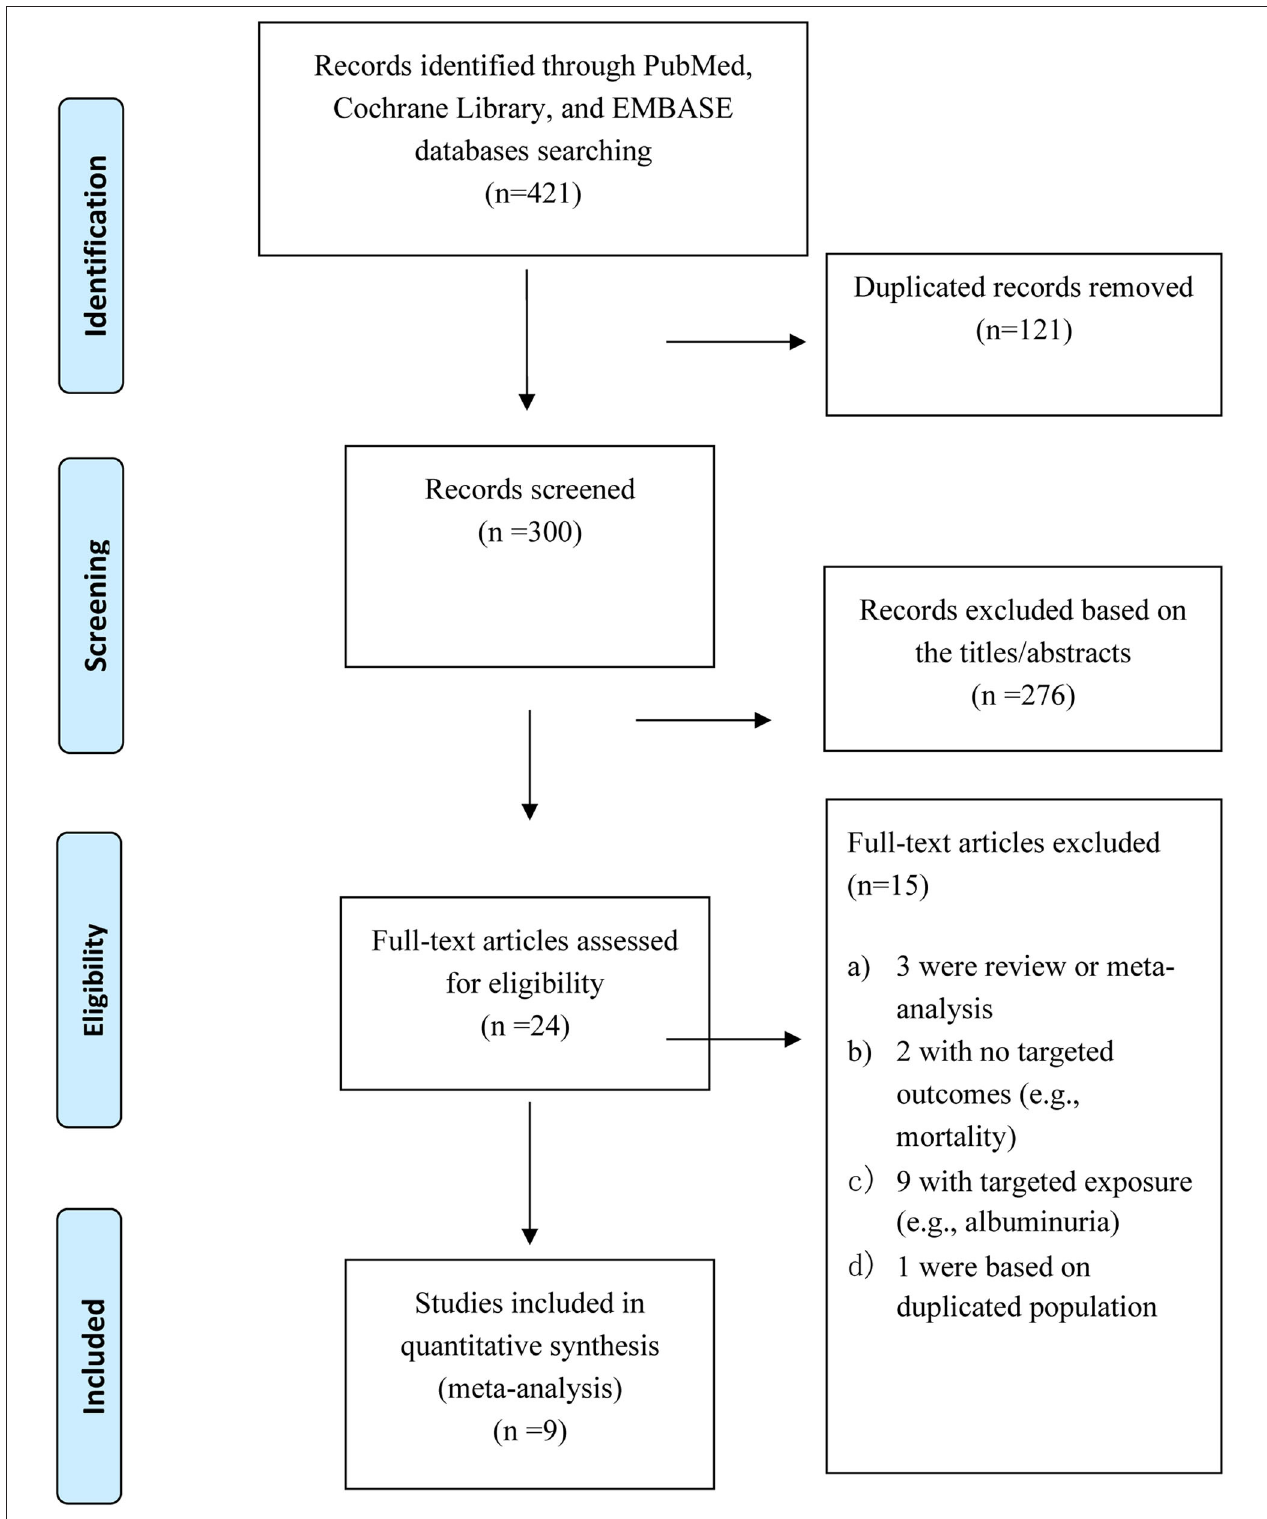
FIGURE 1 | Flow chart of this